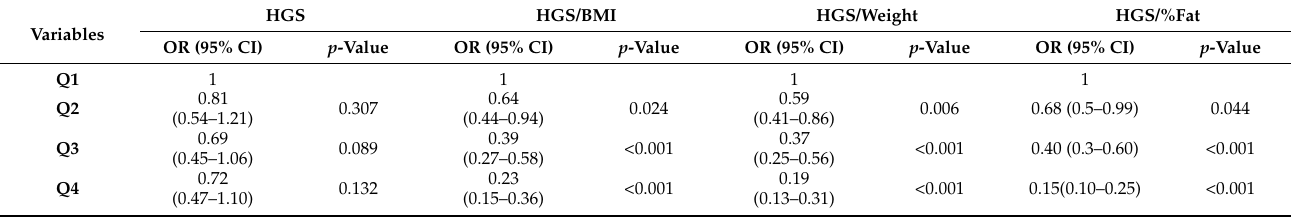
Table 4. Odds ratios of each quartile of handgrip strength, handgrip strength relative to body mass index, handgrip strength relative to weight, and handgrip strength relative to body fat percentage for metabolic syndrome.